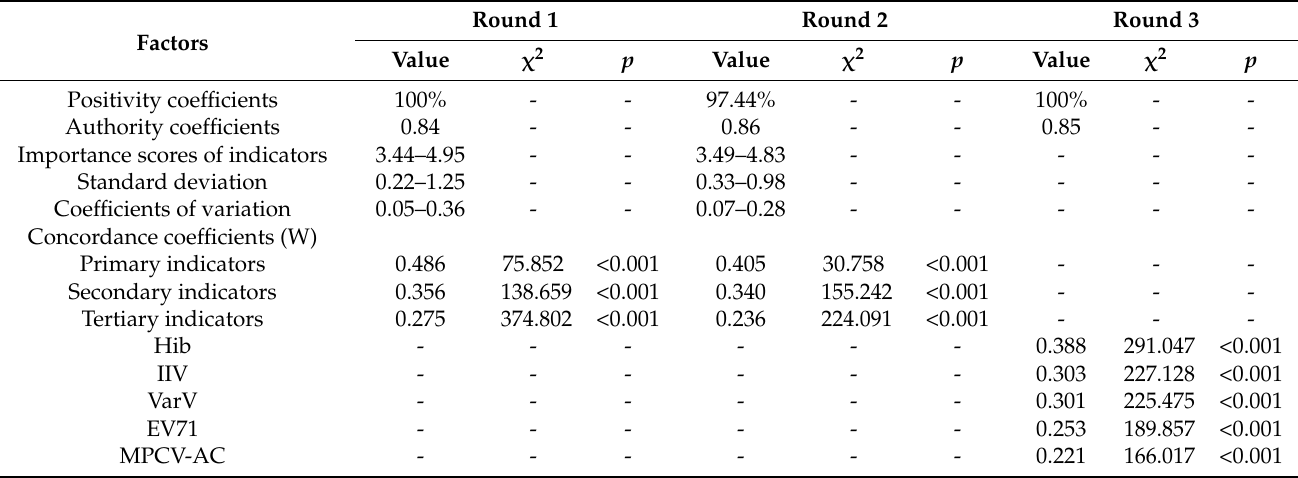
Table 2. Reliability and representation of expert consultation.